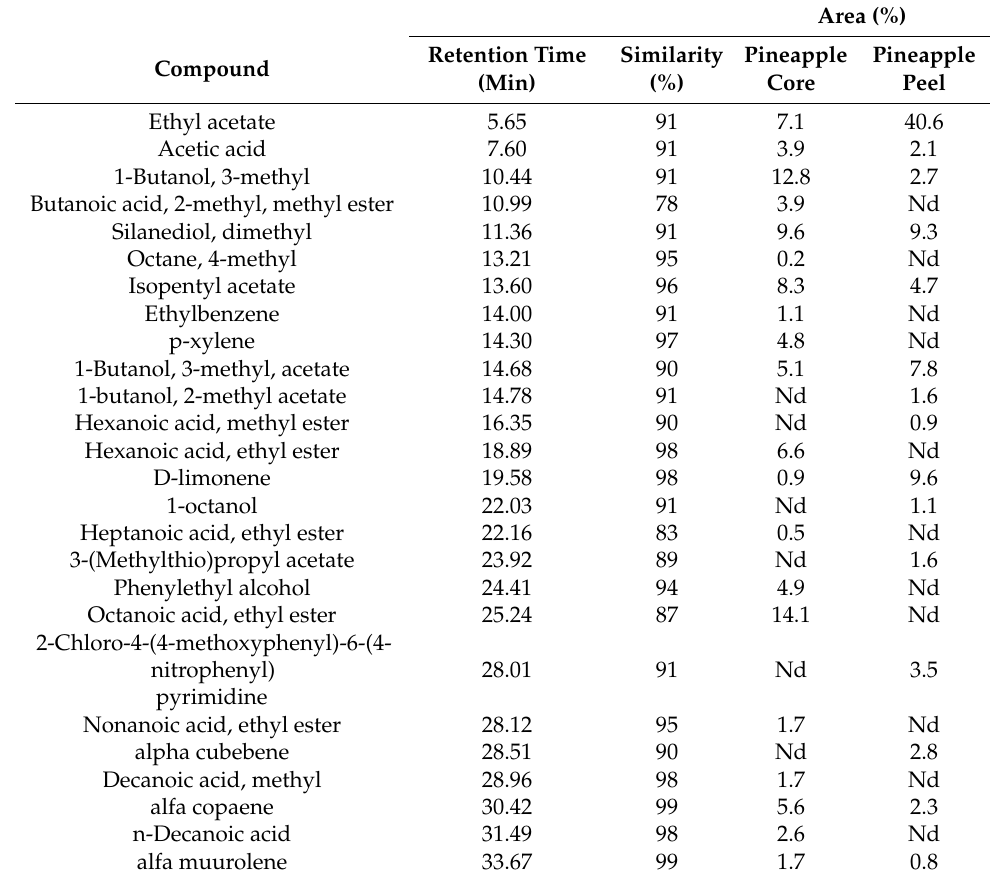
Table 5. Volatile compounds identification. retention times, percentage of similarity (%) and % area (vs. total area) obtained by HS-SPME–GC–MS in core and peel pineapple wastes. Nd: not detected. Area (%) Retention Time Compound